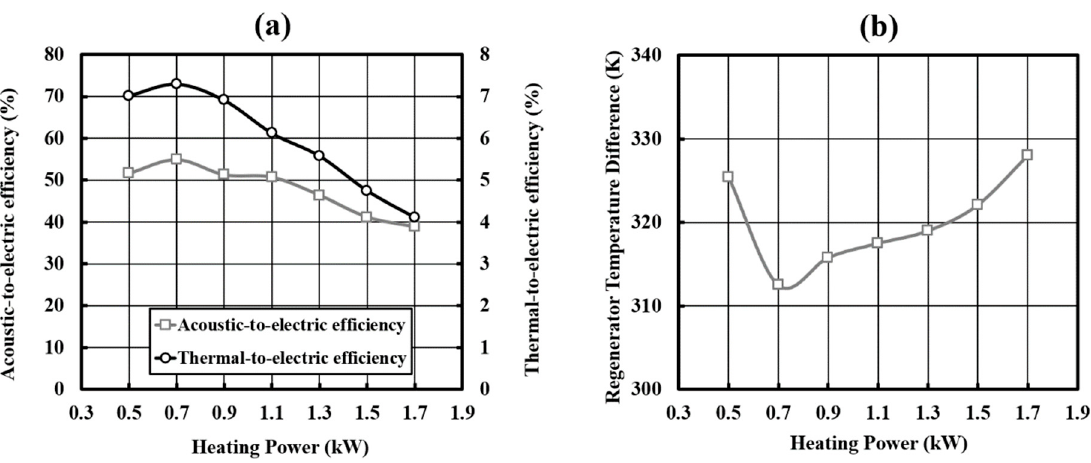
Figure 10. ( a ) Acoustic-to-electric and thermal-to-electric e ffi ciencies vs. heating power; ( b ) Regenerator Figure 10. (a) Acoustic-to-electric and thermal-to-electric efficiencies vs. heating power; (b) temperature di ff erence vs. heating Regenerator temperature difference vs. heating power.